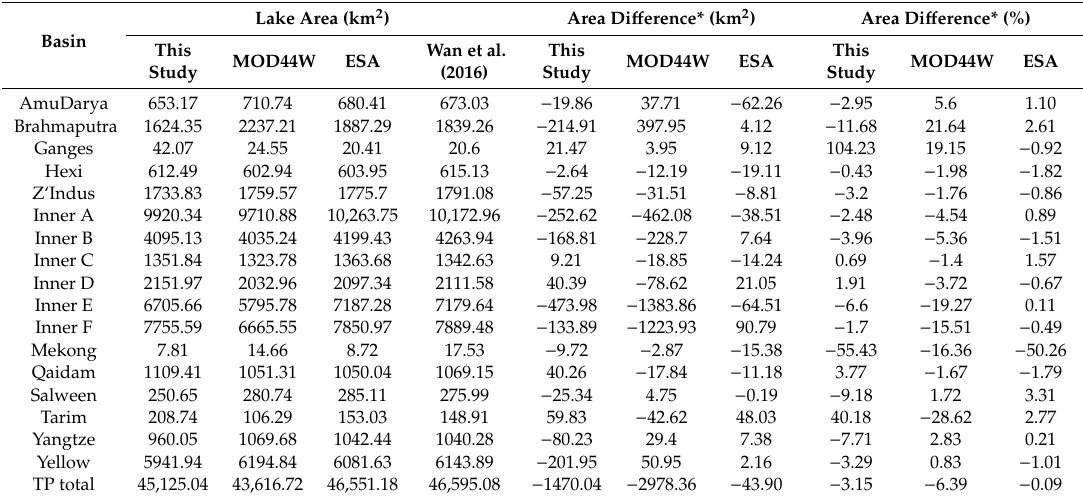
Table 6. Comparisons of the lake areas in 2014 among MODIS water fraction map (this study), the MOD44W, and the TP lake data set by Wan et al. [12] categorized by basins. Lake Area (km 2 Basin